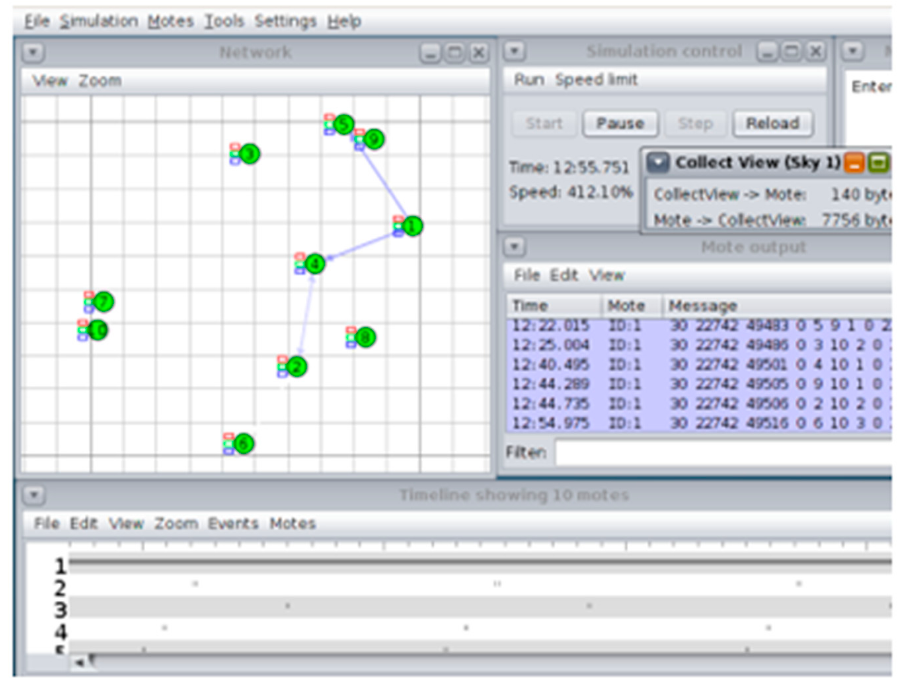
Figure 10. Wireless Sensor Network of the proposed system.